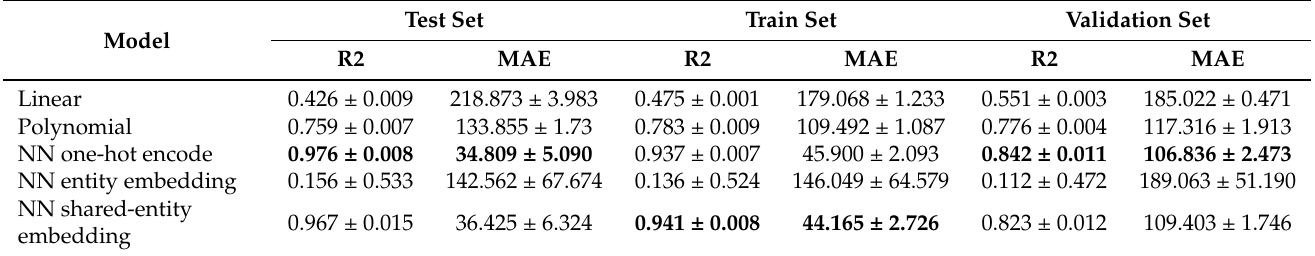
Table 4. Model performance on the dataset using all features. The best performing models are in bold.